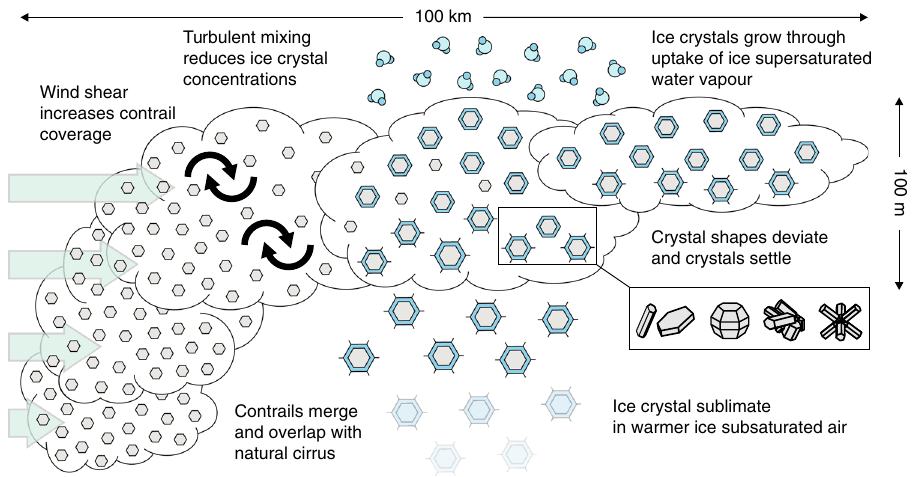
Fig. 5 Factors affecting the development of aircraft-induced clouds. Areal cloud coverage increases due to vertical shear of horizontal wind components. Turbulent mixing (entrainment) forces ice crystal concentrations to decrease (dilute) over time. Ice crystal sizes increase by uptake (deposition) of water vapour from ice-supersaturated layers. Sustained deposition growth causes ice crystal shapes (habits) to deviate from initial isometry. The shapes of ice crystals, which are only poorly known and illustrated as droxtals, hexagonal prisms and columns, bullet rosettes and aggregates, affect their size-dependent growth and fall rates and optical properties. Ice crystals with maximum dimensions >30 µ m settle (sediment) due to gravity with fall speeds >100 m h − 1 and sublimate in warmer or drier air, while smaller crystals remain around the fl ight levels due to negligible fall speeds as long as some supersaturation can be maintained depending on the meteorological situation. The ef fi ciency of sedimentation depends on the depositional growth rate, i.e., on ice supersaturation, the rate of cooling of air, and on ice crystal size, habit and number concentration. Sedimentation increases the vertical extent of AIC, which, in turn, enhances the rate of spreading and therefore coverage in a sheared fl ow. Sustained warming and drying due to large-scale subsidence dissolves AIC entirely. Ice crystal images adapted from ref. 141 with permission from The